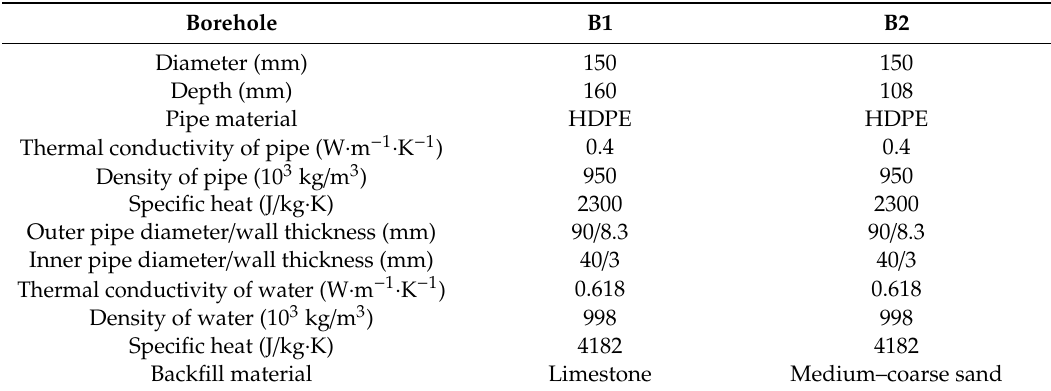
Table 1. Structure parameters of B1 and